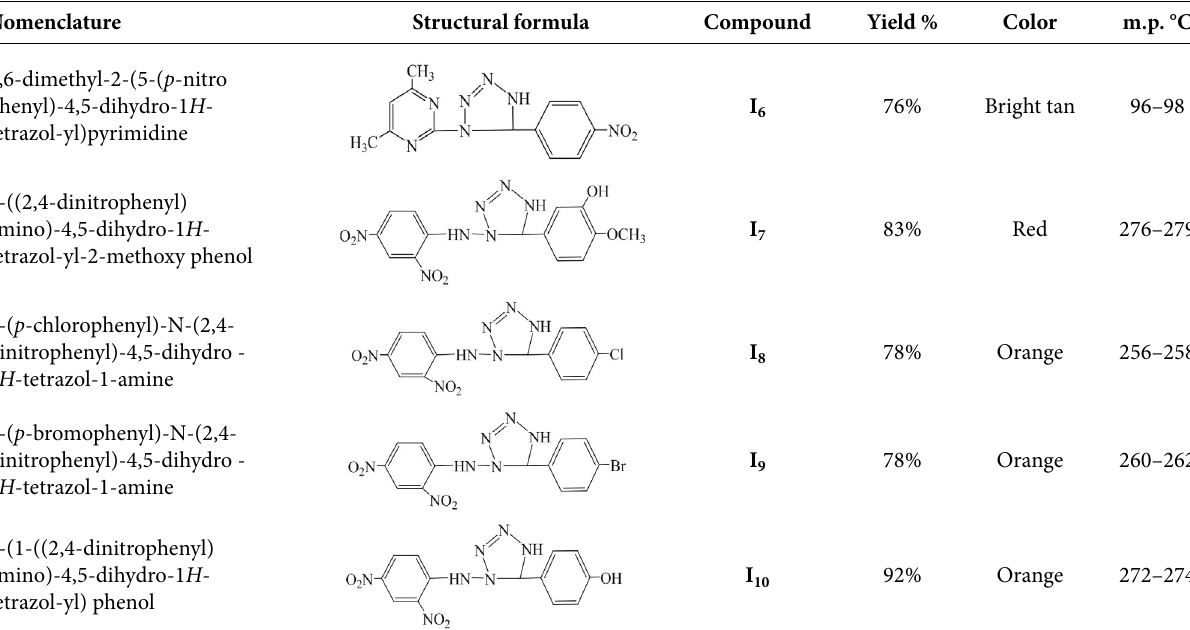
Table 2. Names, structural formulae, symbol, yields, colors and melting points of tetrazole derivatives I 6 –I